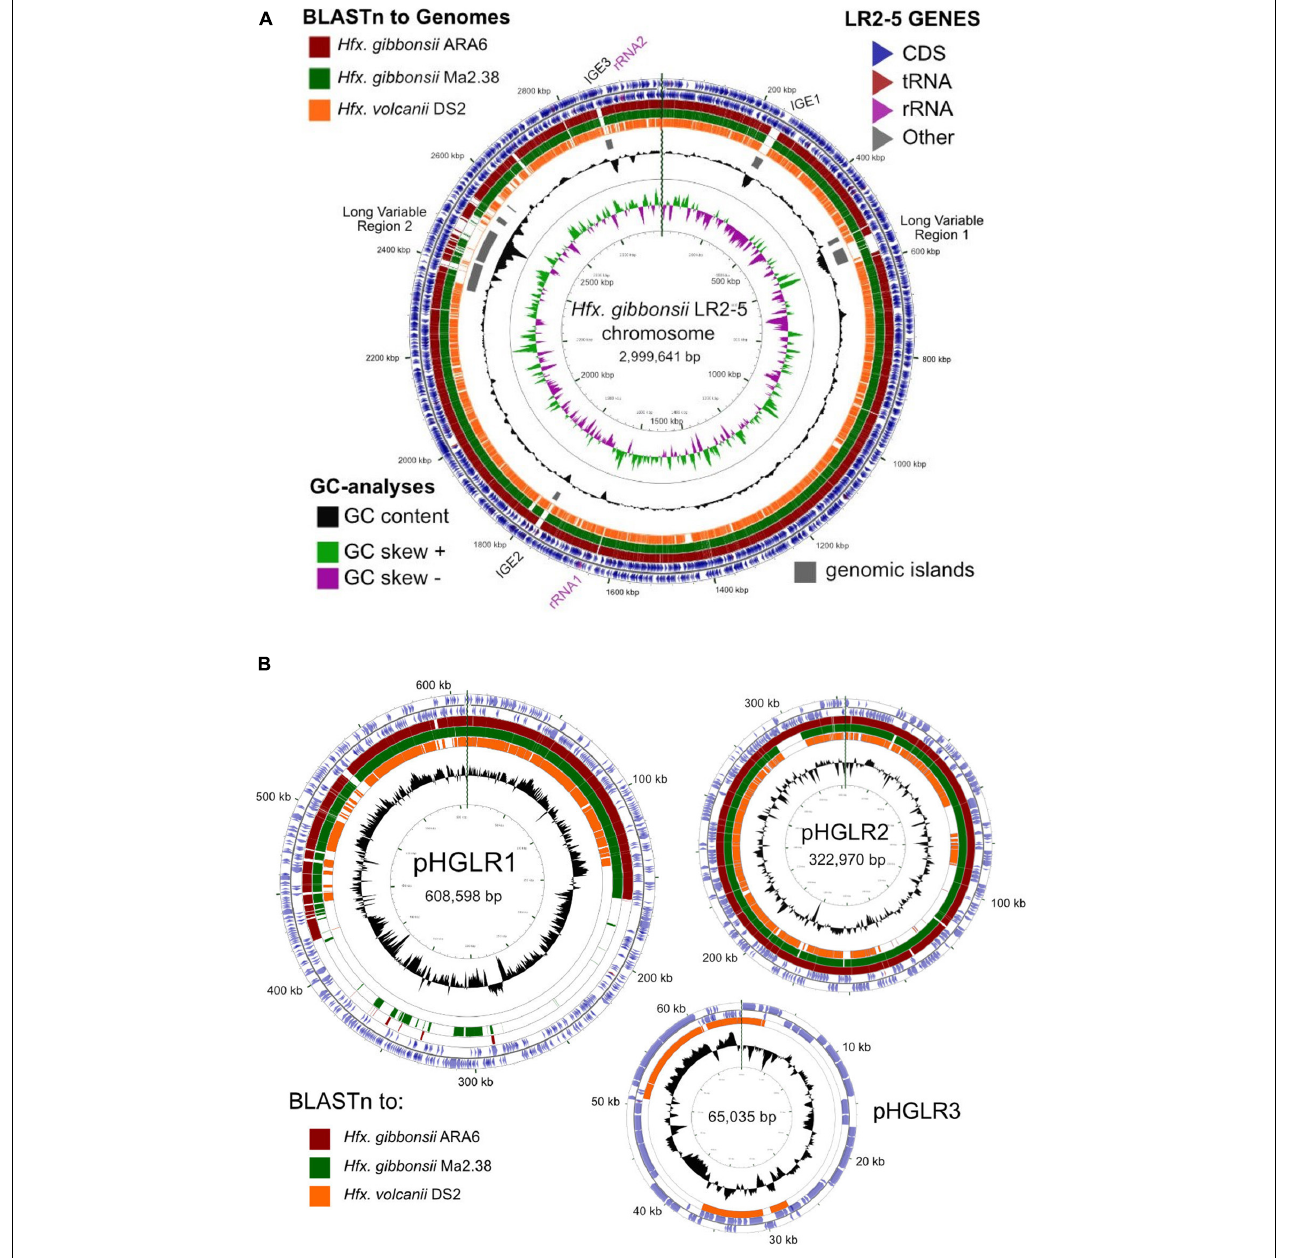
FIGURE 3 | Comparison of the Hfx. gibbonsii LR2-5 chromosome and plasmids to those of three close relatives. (A) Hfx. gibbonsii LR2-5 chromosome map showing similarity to replicons of closely related strains. The two outermost rings depict the annotated genes (CDS, tRNA, and rRNA) of strain LR2-5, for the forward and reverse DNA strands (color key, upper right). Rings 3–5 depict BLASTn similarities between strain LR2-5 and the three strains listed in the color key (upper left). Colored bars represent regions of similarity (Expect value ≤ 10 - 20 , cutoff = 90% nucleotide identity), while uncolored (white) regions represent no significant similarity. Ring 6 (gray blocks) are predicted genomic islands (IslandViewer 4). The two innermost rings represent plots of GC content (black) and GC-skew (green/purple) for strain LR2-5, and the color key for these plots is given in the lower left. The GC content ring plots differences from the average GC%, with outward pointing peaks indicating higher than average, and inward pointing peaks indicating lower than average GC%. IGE1-3, integrative genetic elements (see text). rRNA1 and rRNA2 are the two ribosomal RNA operons. Tick marks around the inner-most and outer-most rings show DNA size in kb. The maps and plots were made using the CGView Server (http://stothard.afns.ualberta.ca/cgview_server). (B) Hfx. gibbonsii LR2-5 plasmid maps showing similarity to replicons of closely related strains. The color key for LR2-5 genes (outer two rings) and the inner GC content plots (black) are as described in (A) . The comparison strains used to produce the BLASTn similarity rings are indicated by the colored boxes lower left. The actual replicons used are as follows. Plasmid pHGLR1 is compared to Hfx. gibbonsii ARA6 plasmid pHG1 (488,062 bp) (red), Hfx. gibbonsii Ma2.38 (green), and to Hfx. volcanii DS2 T plasmid pHV3 (437,906 bp) (orange). Plasmid pHGLR2 is compared to Hfx.